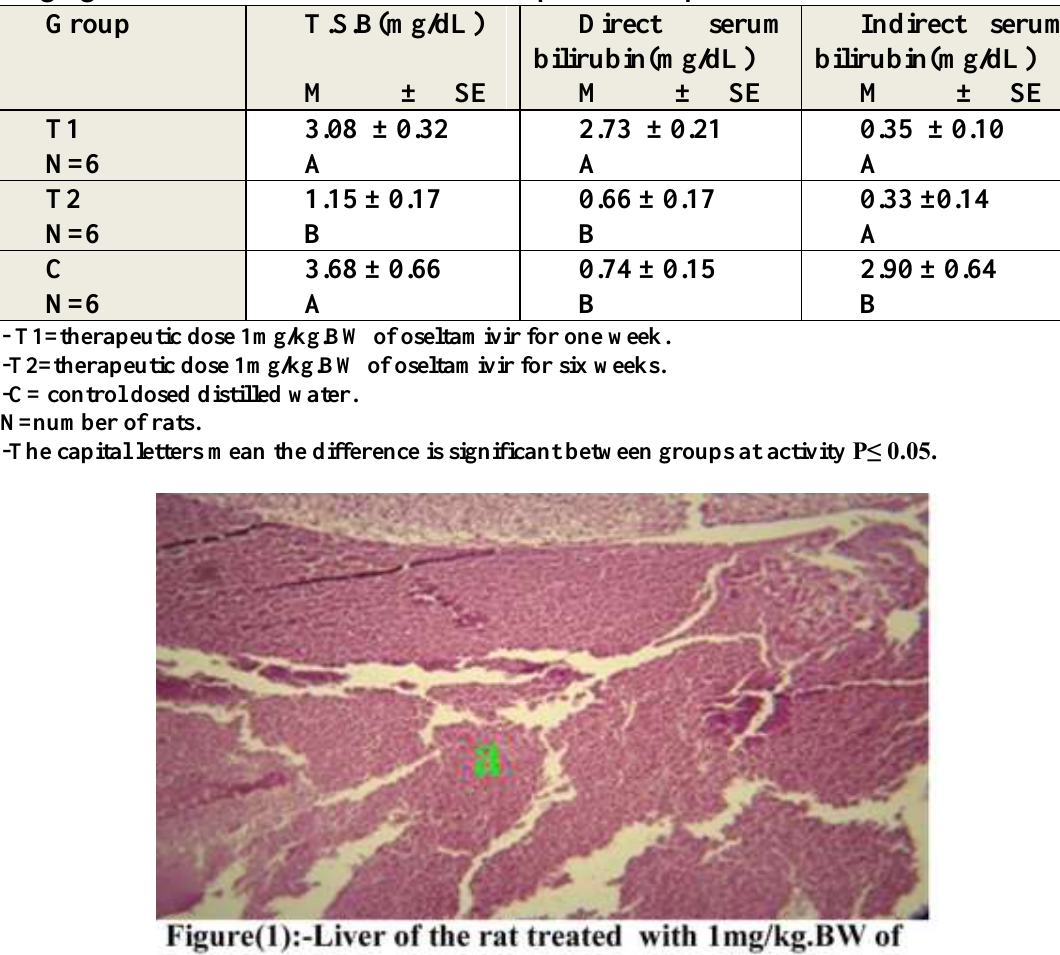
Table (7):- The total serum bilirubin (TSB mg/dL), direct serum bilirubin mg/dL and indirect serum bilirubin mg/dL of rats dosed orally therapeutic dose 1mg/kg.BW of oseltamivir for different experimental periods